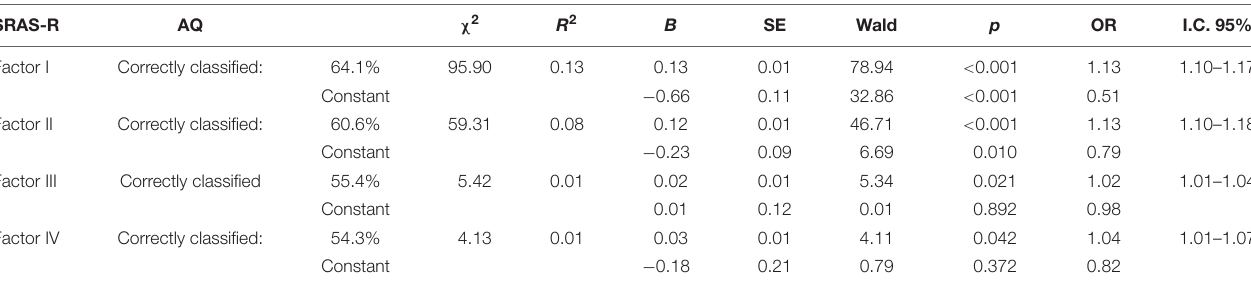
TABLE 8 | Logistic regression model for the probability of presenting high Anger based on the school refusal behavior. SRAS-R